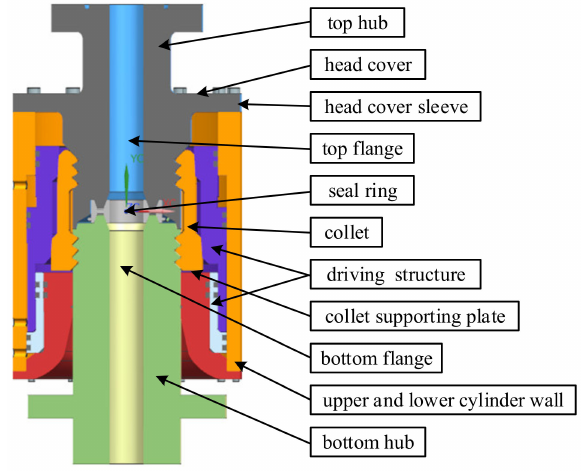
Figure 6. The composition of the wellhead